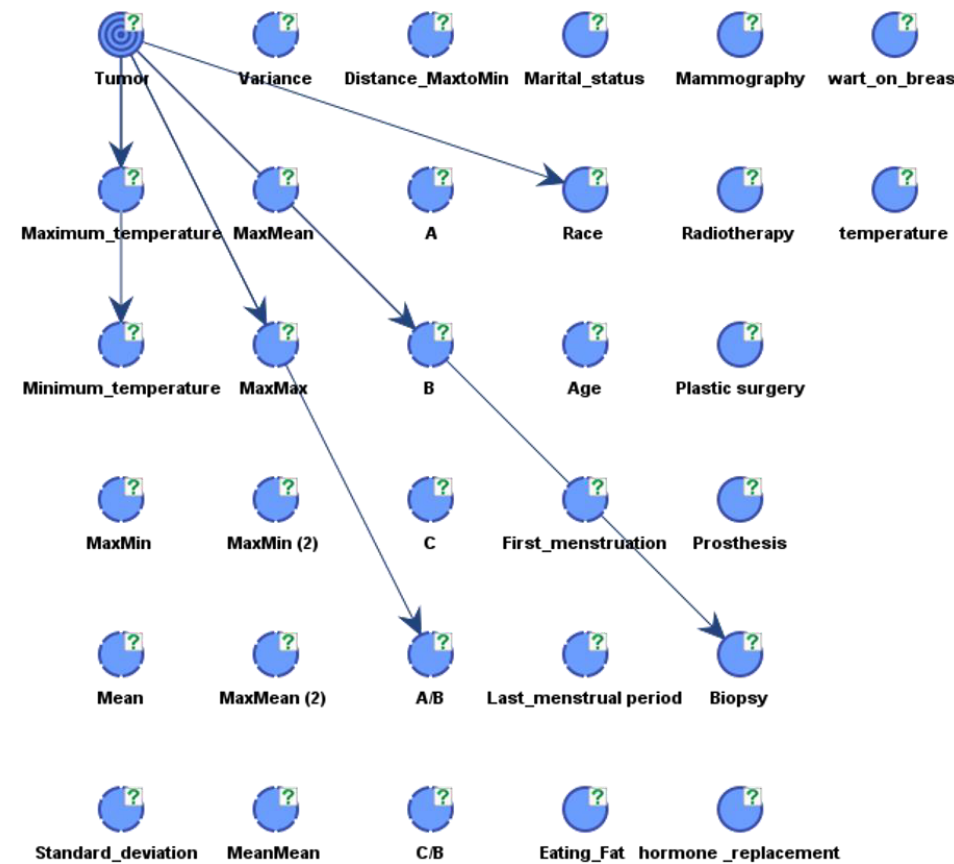
Figure 12. BN influences model for the target variable with supervised learning.